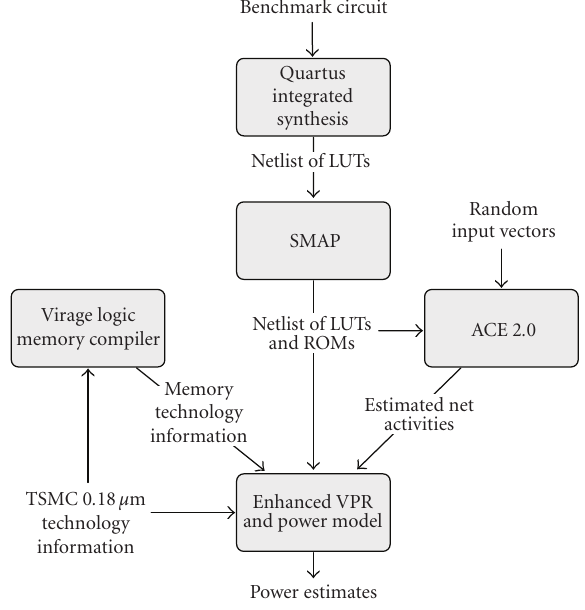
Figure 2: Flow for VPR-based experiments.